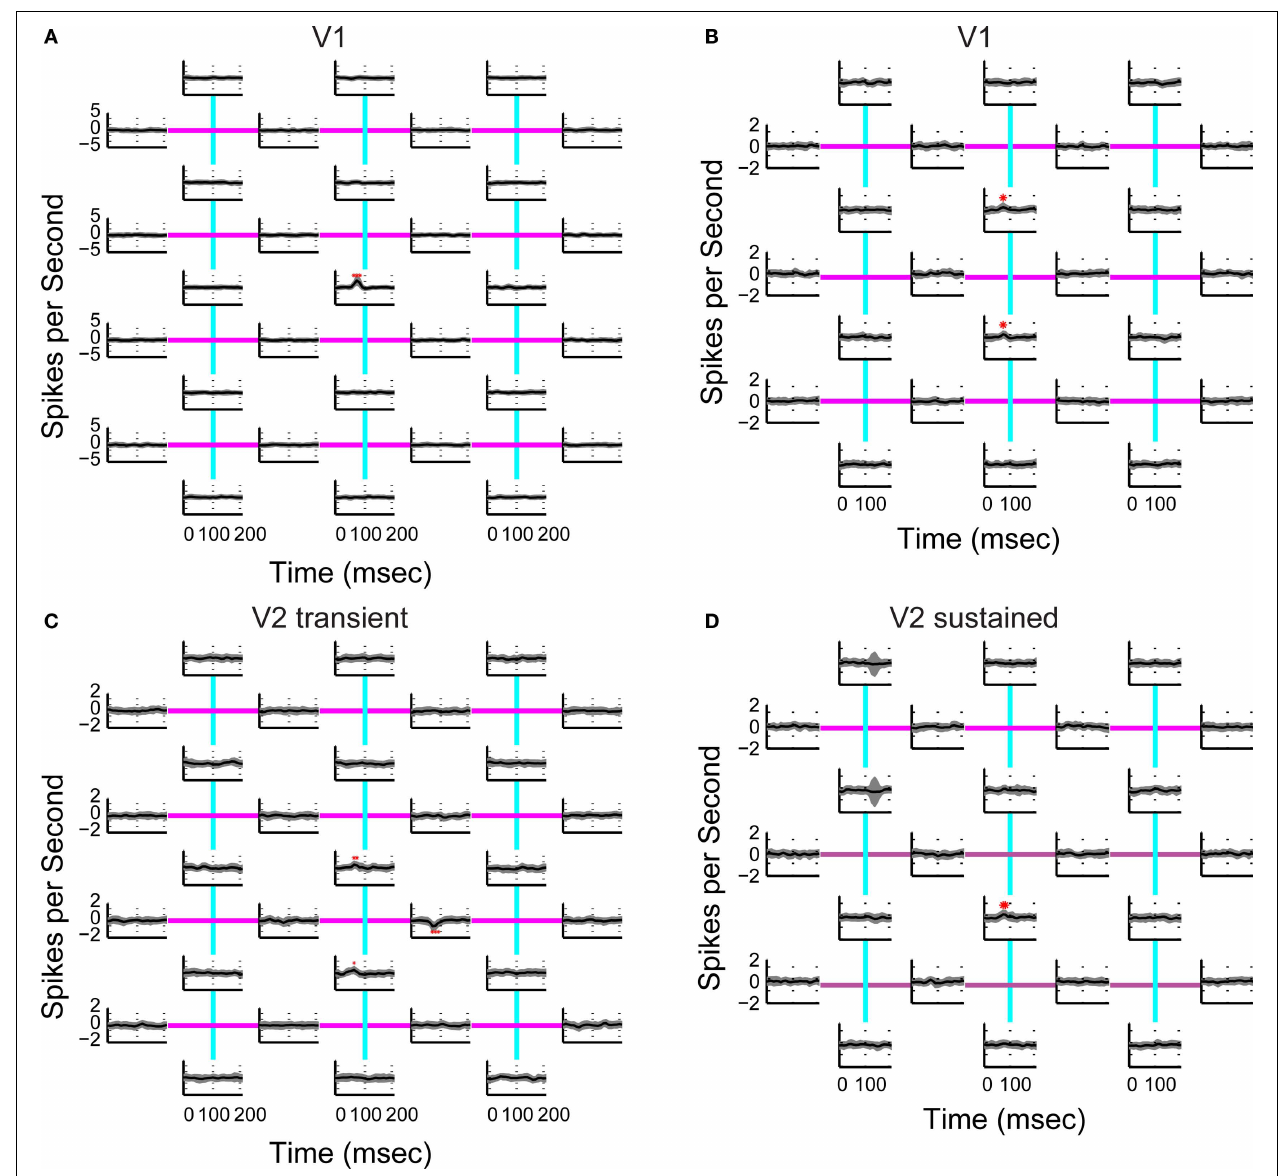
200 ms. (B) Second-order response kernels of another neuron in V1. The layout was 6 × 6 and the check size of the stimulus 0.4 × 0.4 degrees of visual angle. Only kernels for a 4 × 4 subregion centered on the receptive fi eld are shown. (C) Second-order response kernels of a ‘transient’ neuron in V2 (same as in Figure 2C ). (D) Second-order response kernels of a “sustained” neuron in V2. The layout was 6 × 6 and the check size of the stimulus 0.4 × 0.2 degrees of visual angle. Only kernels for a 4 × 4 subregion centered on the receptive fi eld are shown. The large standard deviation, without signifi cant change in the mean response, in two of the subpanels in panel (D) stem from fi rst-order responses that have been removed by the inverse-repeat method, not random variation (see “Stimulation with Orientation-Discontinuity